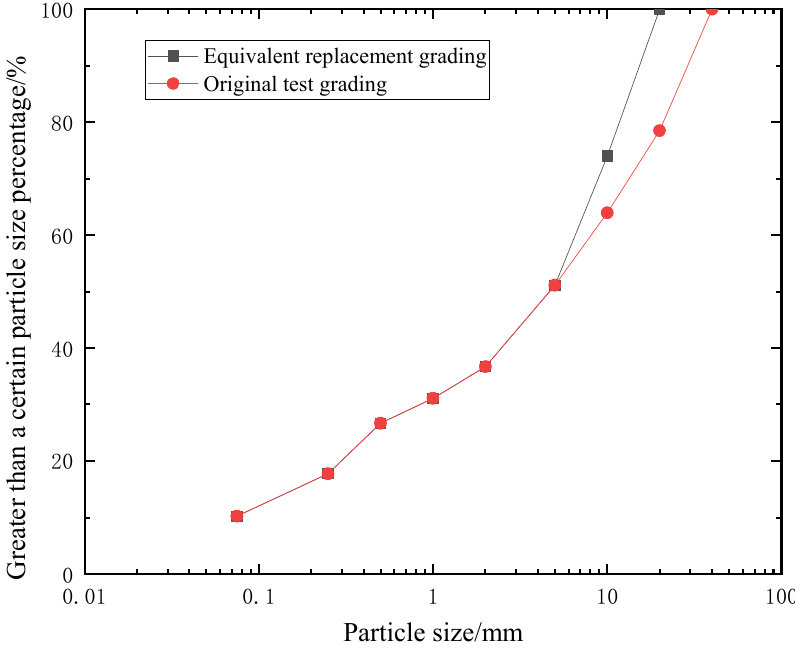
Figure 1. Comparison between original grading and equivalent replacement grading.